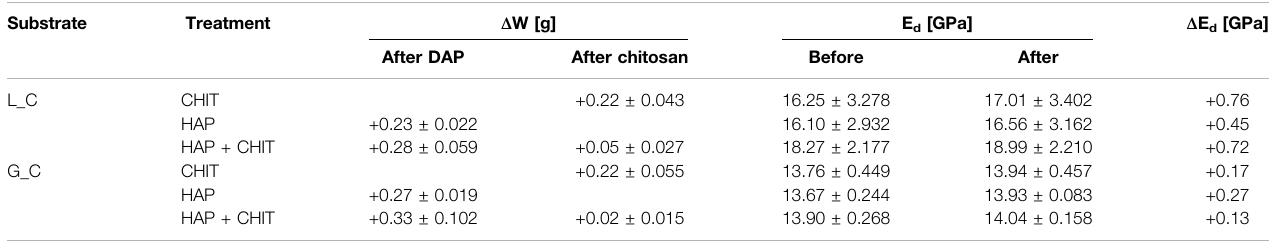
TABLE 1 | Characteristics of cylindrical samples: mass variation after treatment in dry condition ( Δ W), dynamic elastic modulus before and after treatment (E d ), variation of dynamic elastic modulus ( Δ E d ). Substrate